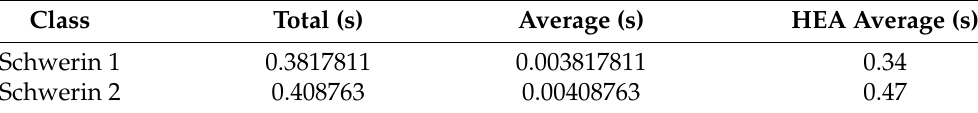
Table 3. Running times of the Schwerin benchmark problems, compared to HEA